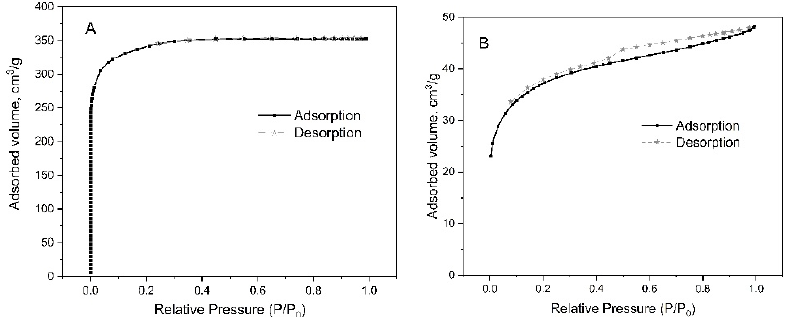
Figure 8. Microstructure SEM—magnification 130× of PTFE-C composite plate SPC ( A ) and elemental analysis (EDS) of carbon ( B ) and fluor ( C ) distributions.